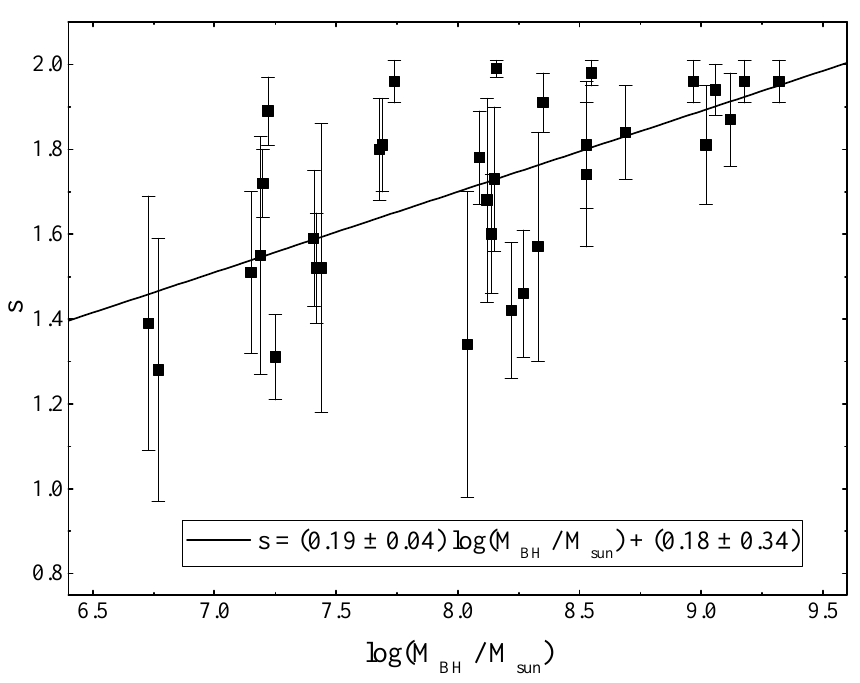
Figure 9. Dependence of the exponent of the power-law dependence s on the SMBH mass M BH .